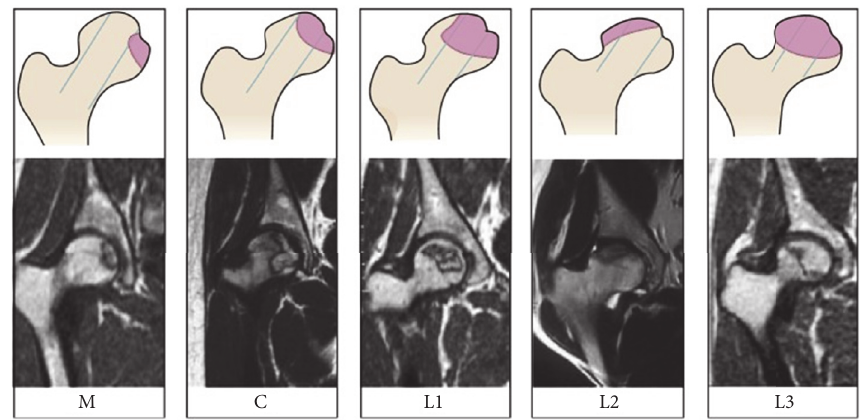
Figure 1: Schematic diagram and magnetic resonance image of China-Japan Friendship Hospital (CJFH) classification for osteonecrosis of the femoral head based on three pillars [19]. Type M: necrosis involves the medial pillar. Type C: necrosis involves the medial and central pillars. Type L1: necrosis involves the three pillars but the partial lateral pillar was preserved. Type L2: necrosis involves the entire lateral pillar and part of the central pillar. Type L3: necrosis involves the three pillars including the cortical bone and marrow.